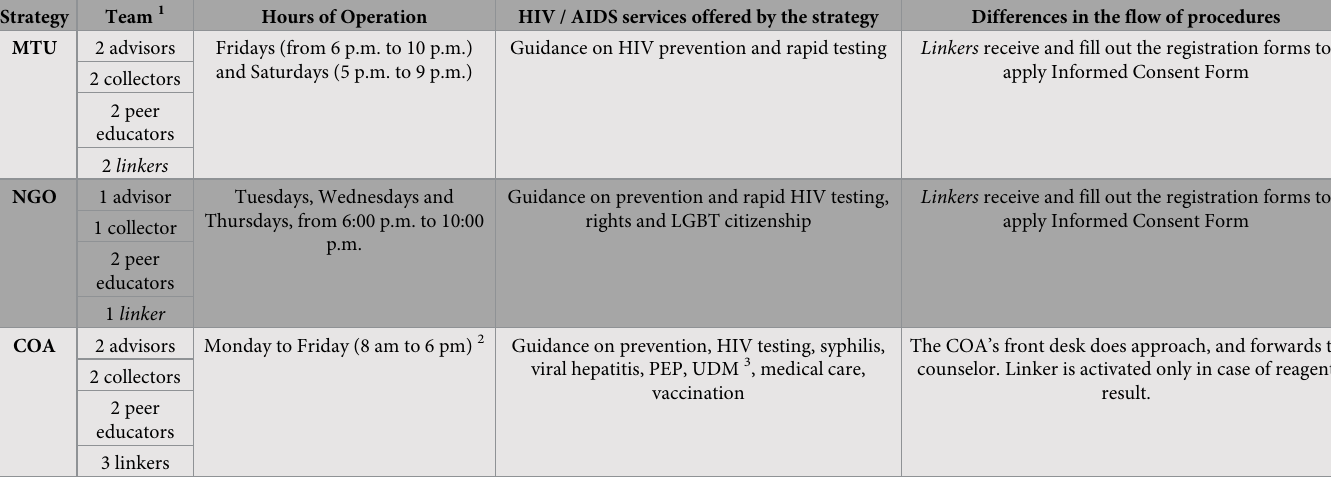
Table 1. Structure of AHA voluntary counseling and testing (HTC) services—Curitiba/PR/Brazil—03/01/2015 to